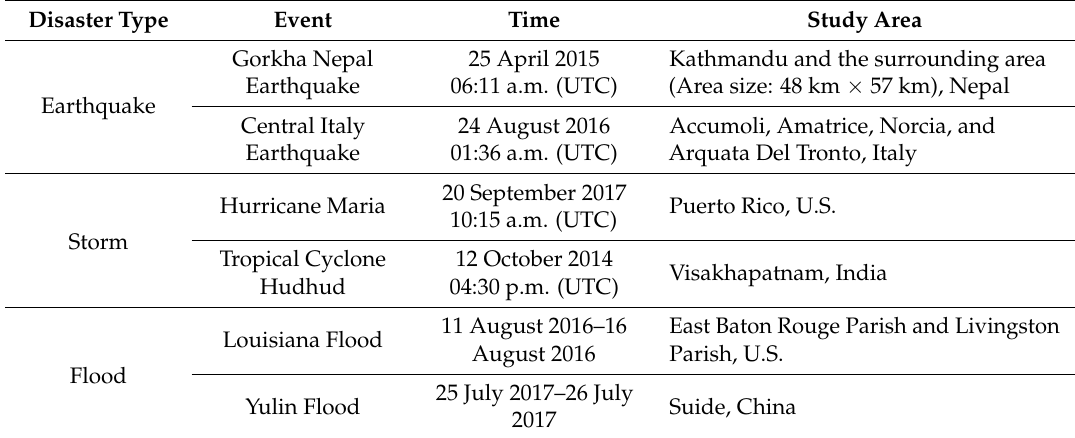
Table 1. The selected disaster events and study